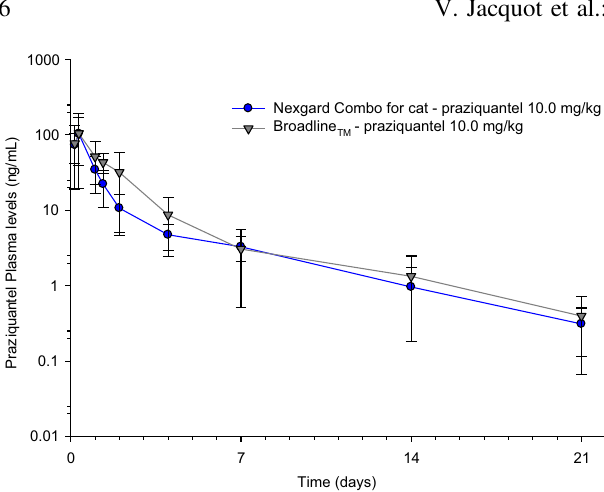
Figure 2. Praziquantel average concentration – time curves, when administered in NexGard (cid:1) Combo, or in Broadline (cid:1) .